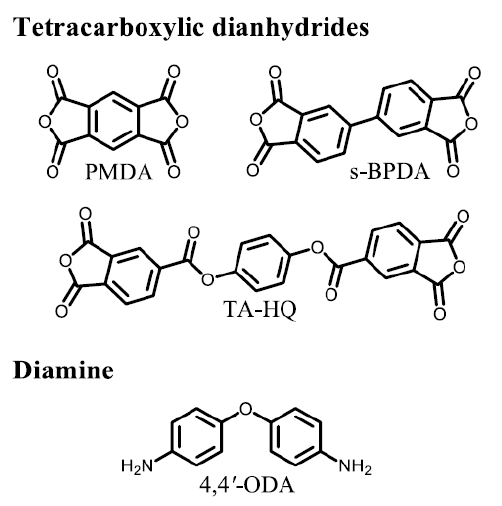
Figure 3. Structures and abbreviations of the common monomers used in this study.